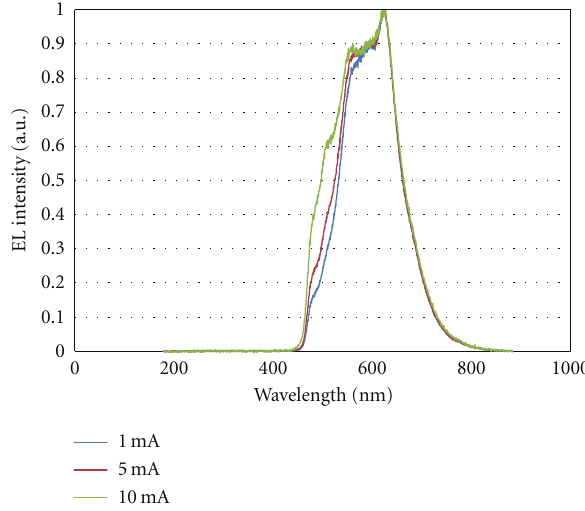
Figure 5: EL spectra in sample A. Injected currents are 1, 5, and 10mA.